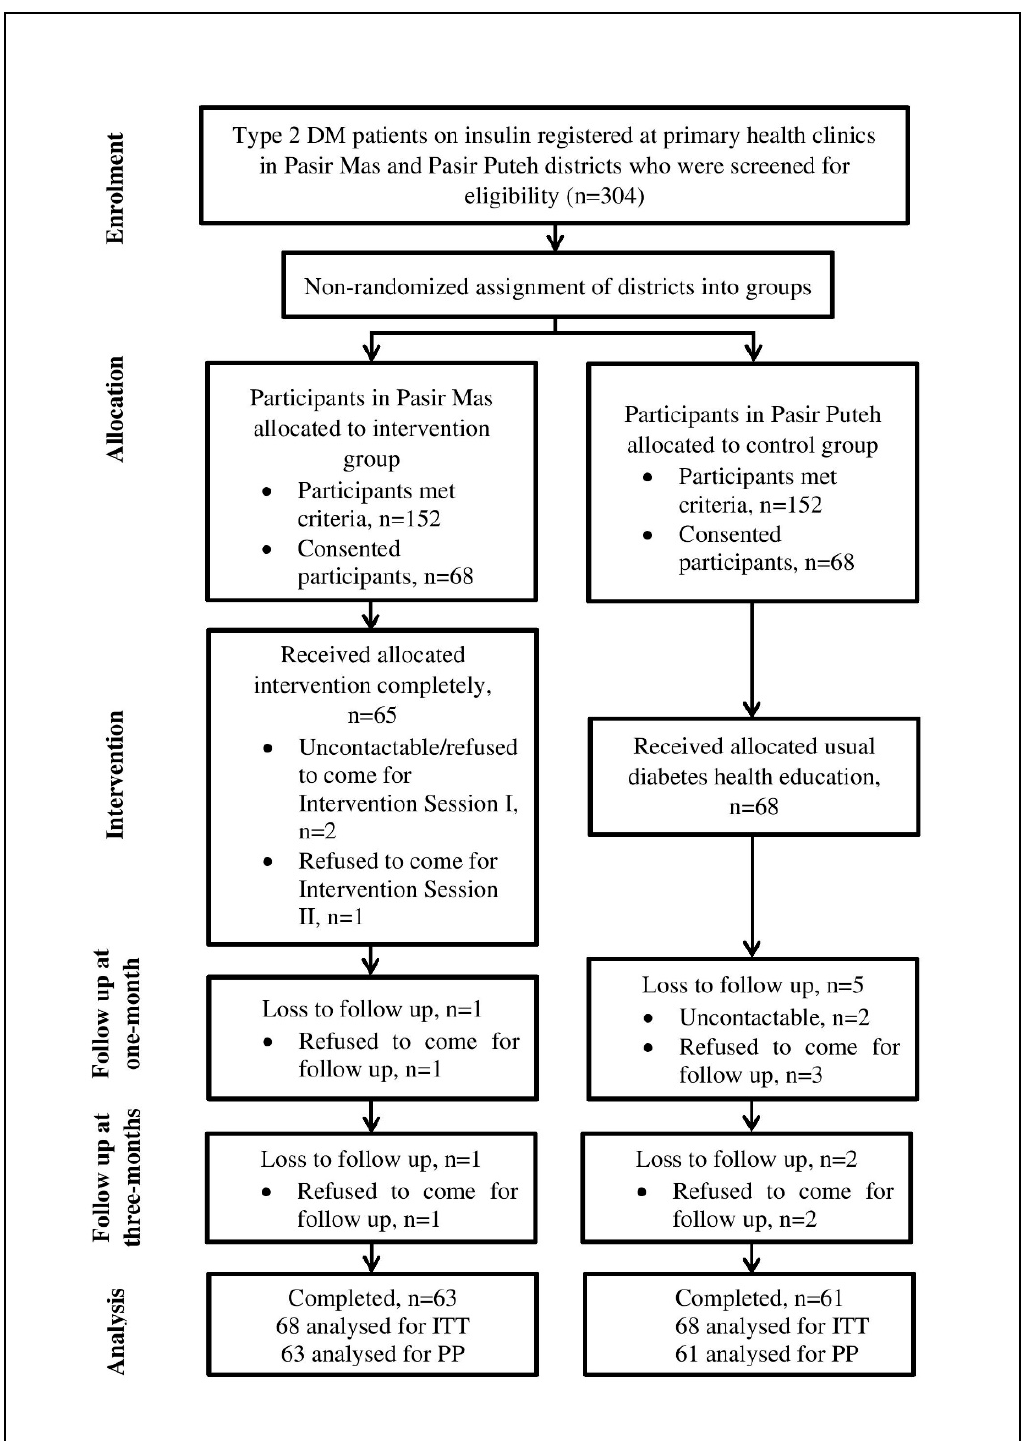
Figure 1. Flow diagram of progress in the intervention study based on Transparent Reporting of Evaluations with Nonrandomized Designs (TREND) statement.